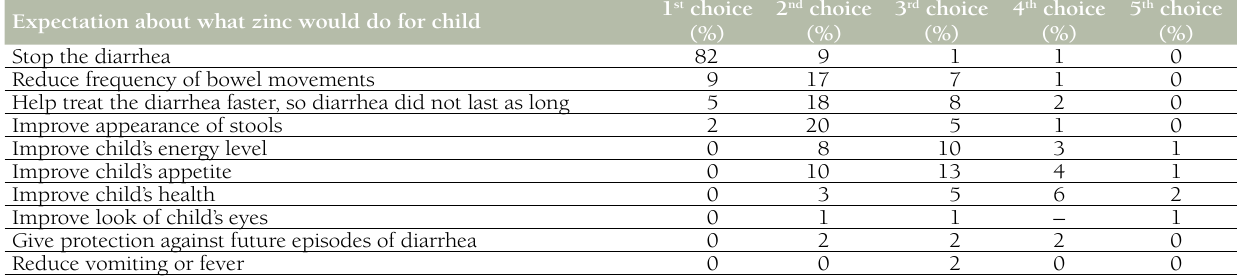
Table 7. Caregivers’ expectations for zinc treatment based on experience (n = 100 respondents) Expectation about what zinc would do for